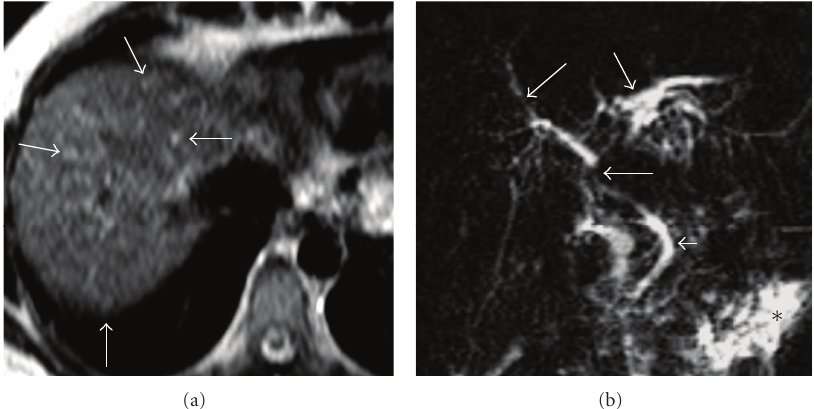
Figure 4: Axial T 2 -weighted sequence (a) shows multiple round lesions with high signal. The diameter of lesions is less than 10 mm, referring to telangiectasias (arrows). They are di ff usely scattered throughout the liver and prevalently peripheral arrangement. MRCP sequence (b) shows contour irregularities multiple focal strictures and dilatation of the biliary tract (arrows) with a “pruned tree” appearance. Contour irregularity of the common bile duct wall is seen (arrowhead). ( ∗ )